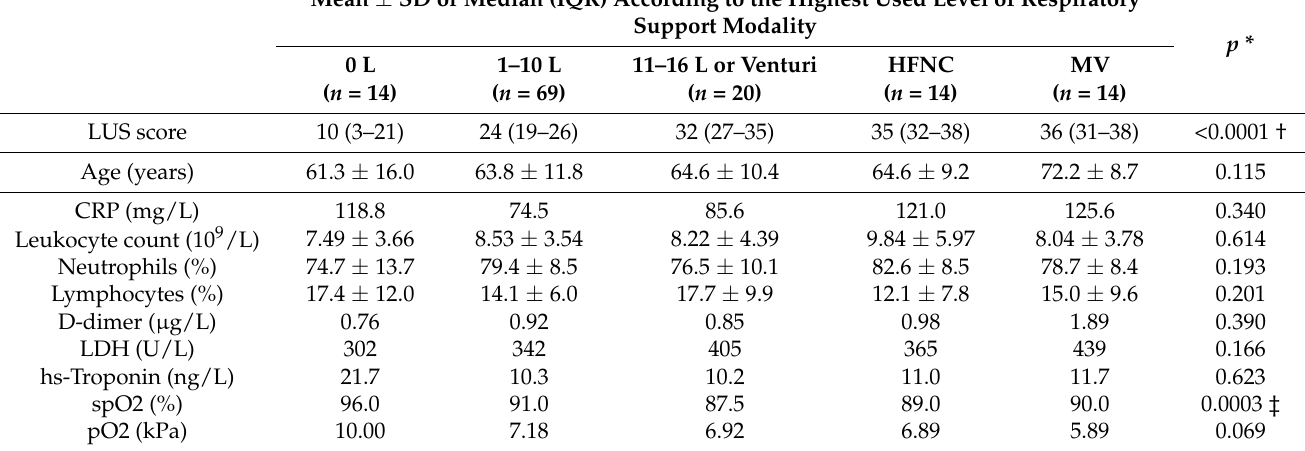
Table 3. Biochemical parameters according to the highest level of respiratory support